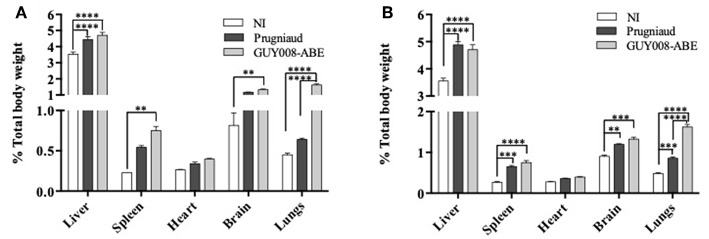
Ponderal indexes of rat organs following Toxoplasma gondii infection. Rats were intraperitoneally infected with 107 tachyzoites of type II Prugniaud (n = 8) or Guy008-ABE (n = 8) strains. Un-infected (NI) rats were used as controls (n = 3). Animals were sacrificed at days 4 (A) or 14 post-infection (B). Percentages of organs weight regarding total animal weight were calculated and mean ± SEM represented. Values were submitted to 2way ANOVA analysis followed by a Tukey's multiple comparisons test (**p < 0.005, ***p < 0.0005, ****p < 0.00005).